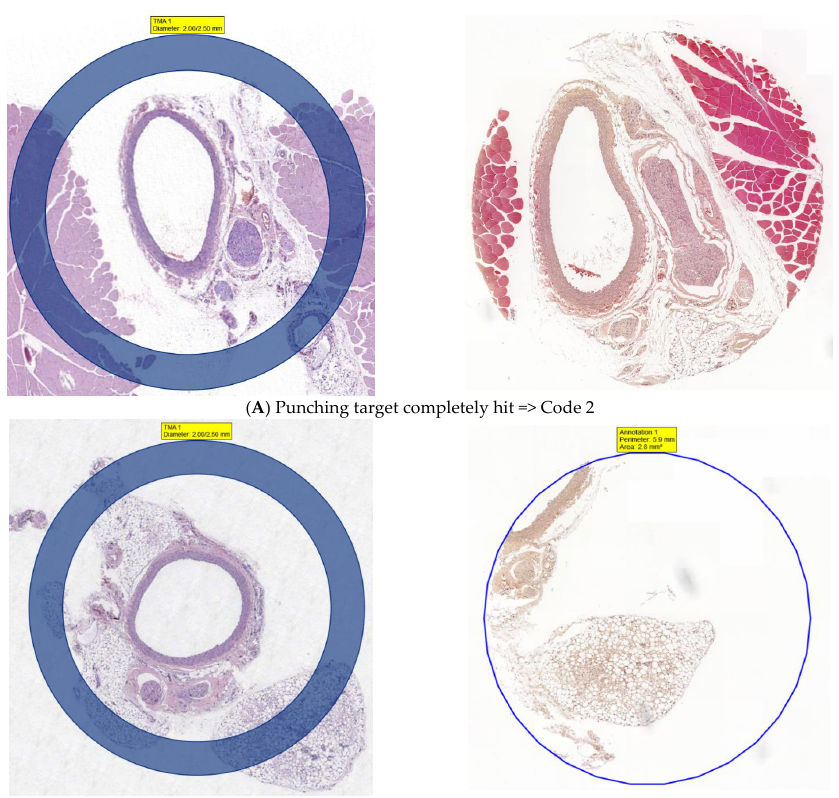
Figure 4. Example of the qualitative analysis. The left picture shows the digitalised H&E slide of the donor block with its annotation marking the carotid artery and the vagus nerve. The right image shows the corresponding core on the TMA H&E slide. ( A ) is an example of a structure ‘ completely hit ’ , which leads to code 2. Note the different shapes of the artery and the nerve between the left and the right image, resulting from the 3-dimensional passage of the structures through the surrounding tissues. ( B ) is an example of a structure ‘ partially hit ’ . The nerve was hit, but the aorta is only partially captured. This leads to code 1. Appl. Sci. 2021 , 11 , x FOR PEER REVIEW